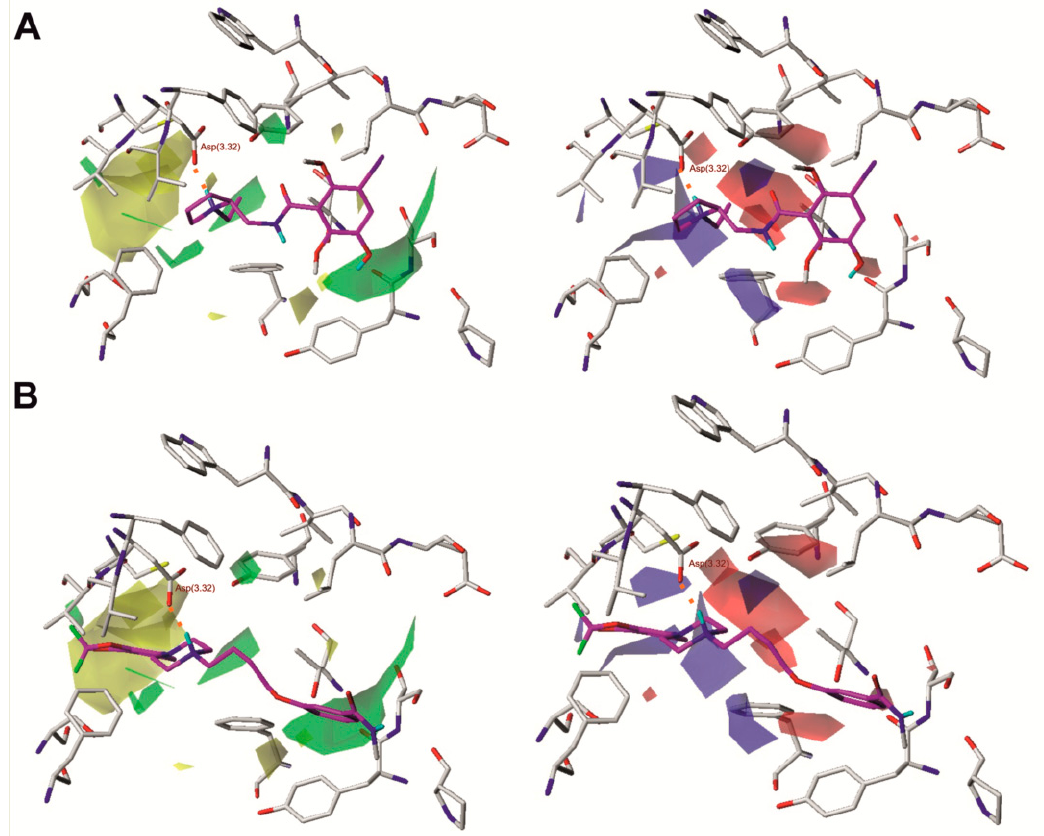
Figure 3. Comparative molecular field analysis (CoMFA) steric and electrostatic fields projected on the 3D structure of the dopamine D 2 receptor in complex with compound 1 ( A ) and compound 17 ( B ). Ligands are shown as sticks with magenta representing carbon atoms. Receptors are shown as wires with grey representing carbon atoms, while the main interacting residues are represented as sticks. Hydrogen bonds are depicted as red dashed lines. Nonpolar hydrogen atoms are not shown for clarity.